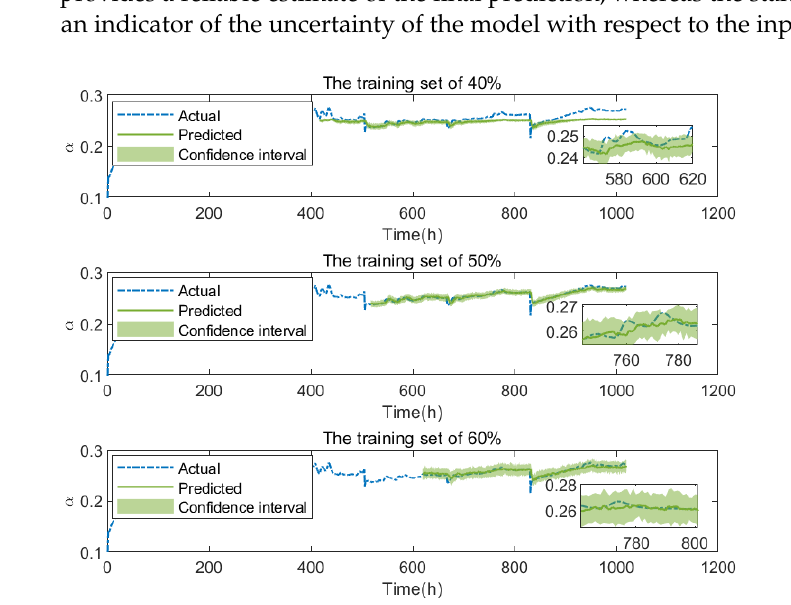
Figure 8. The degradation prediction of FC2 with different training set sizes.